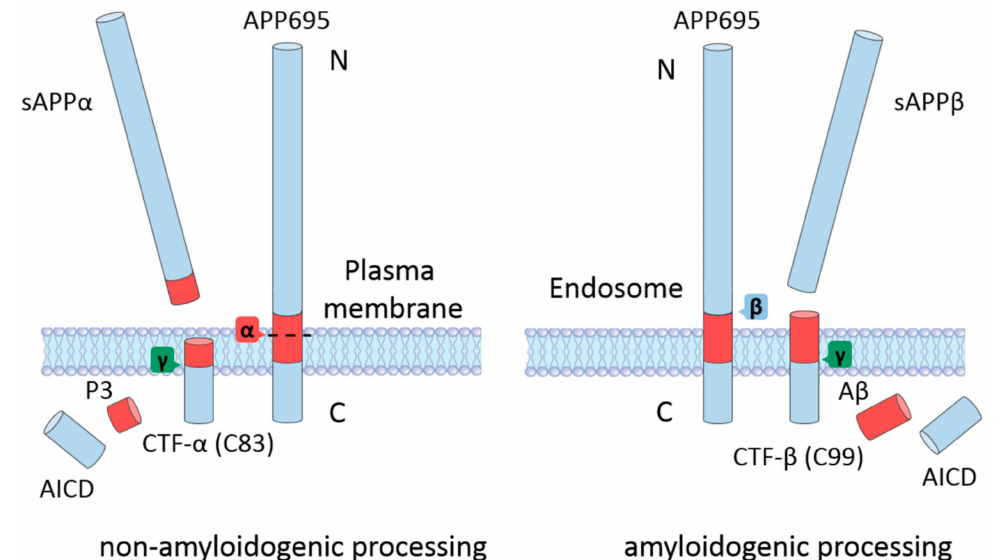
Figure 1. The proteolytic cleavage of the amyloid precursor protein (APP) by the non-amyloidogenic ( left ) and amyloidogenic ( right ) processing pathways. In the non-amyloidogenic pathway, mature APP anchored to the plasma membrane is processed by α -secretase within the amyloid- β (A β ) region (shown in red) and releases soluble APP α (sAPP α ) and the C-terminal fragment- α (CTF- α ). The CTF- α is further processed by γ -secretase to generate P3 and the APP intracellular domain (AICD). In the amyloidogenic pathway, which preferentially occurs in acidic environments such as endosomes, reinternalized APP is consecutively cleaved by β - and γ -secretase to produce soluble APP β (sAPP β ), A β , and AICD. The C-terminal fragment- β (CTF- β ) is an intermediate product of the β -secretase